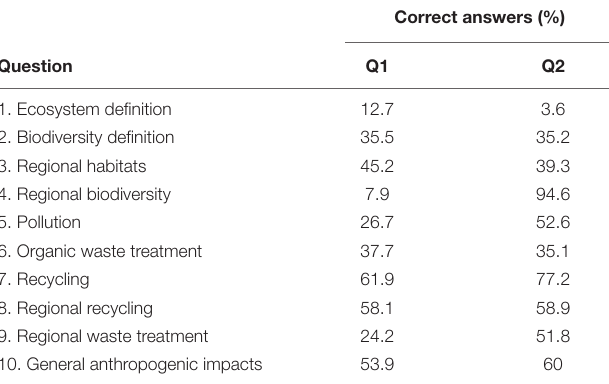
Correct answers